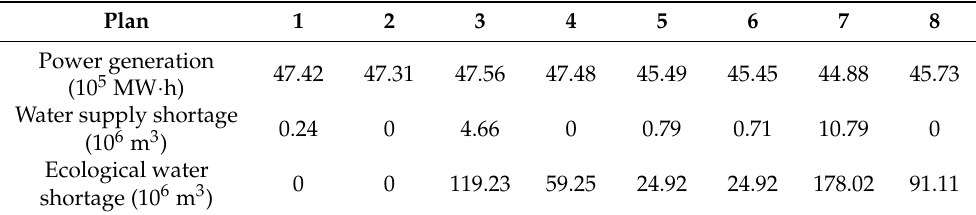
Table 7. The set of typical plans calculated by the MTIM and MTNM in a dry year.